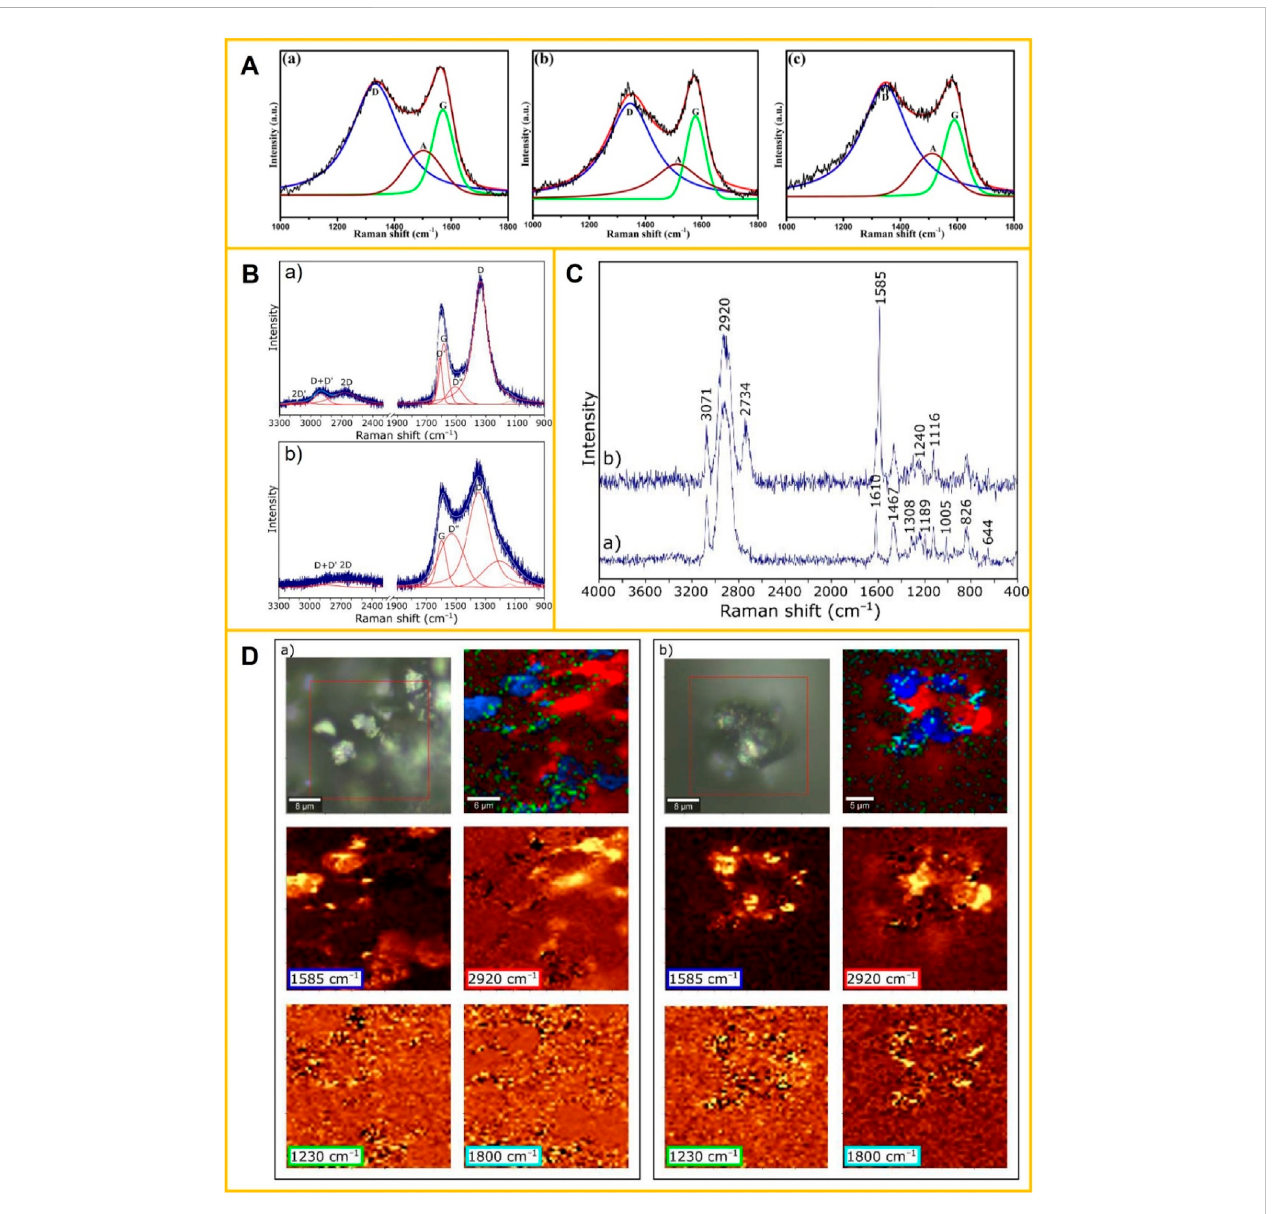
FIGURE 7 (A) Raman spectra and curve fi tting for the CFs: (a) untreated CF, (b) CF-OH, and (c) CF-cardanol. Reprinted with permission from (Zheng et al., 2020). Copyright2020MDPI(Basel,Switzerland). (B) Ramanspectrum(a)ofgrapheneoxide(GO)and(b)ofthevirgincarbon fi bers(CFs).Adaptedwithpermissionof (Floreket al.,2021). Copyright2021 MDPI(Basel,Switzerland). (C) Ramanspectra of (a)epoxy resin and (b)graphene oxide particle. Reprintedwith permission from(Floreketal.,2021).Copyright2021MDPI(Basel,Switzerland). (D) Ramanimagesof(a)thereferenceCFRPcompositeand(b)theCFRPsamplewith 0.3% GO addition. Reprinted with permission from (Florek et al., 2021). Copyright 2021 MDPI (Basel,